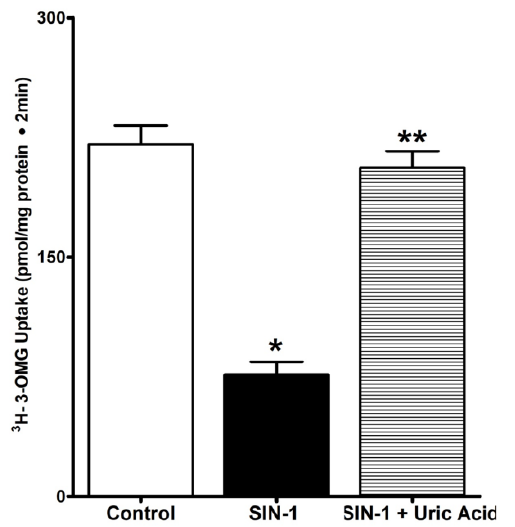
Figure 4. Uric acid prevents abundant peroxynitrate (OONO) effect on SGLT1 activity. SIN-1 treatment significantly diminished the SGLT1 activity in IEC-18 cells. Uric acid, a natural scavenger for peroxynitrite, prevented the effect of SIN-1 treatment on SGLT1 activity in IEC-18 cells. Thus, these data show that the inhibition of SGLT1 activity was due to peroxynitrite produced from SIN-1 treatment. n = 3, * p < 0.01 (control Vs SIN-1), ** p < 0.05 (SIN-1 vs. SIN-1 + Uric acid).